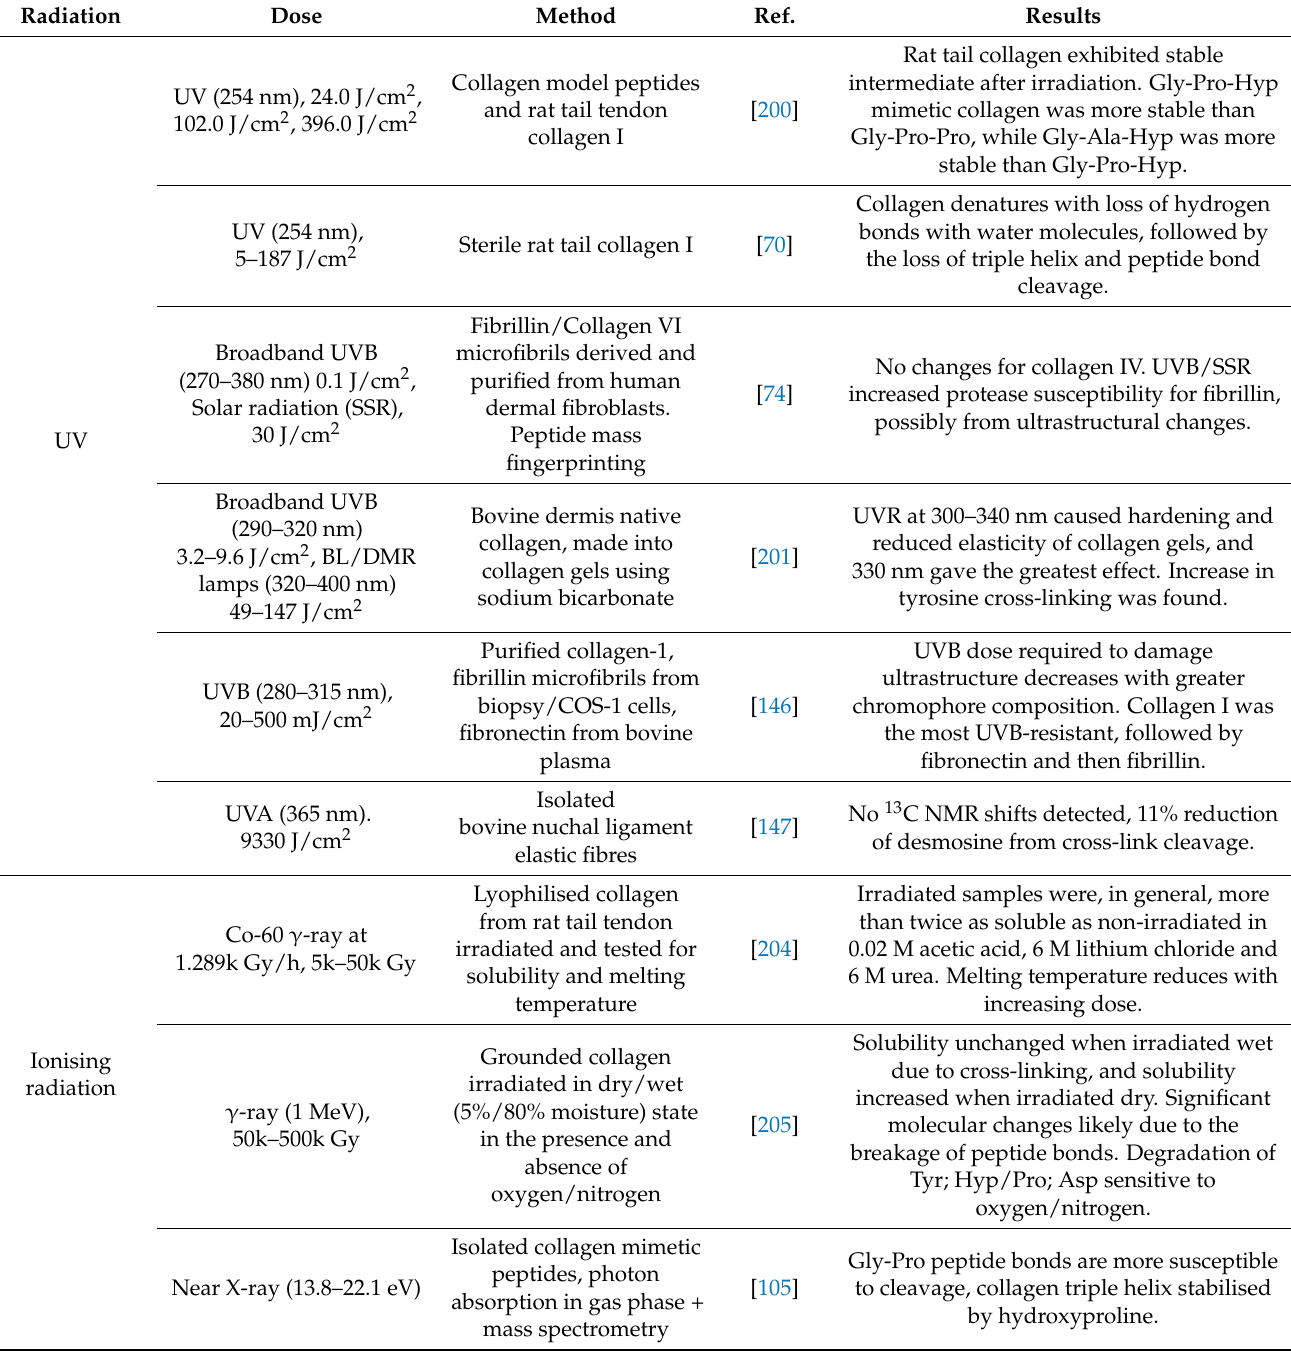
Table 2. Selected studies utilising purified ECM proteins for radiation damage experiments are useful to elucidate molecular mechanisms of radiation responses for individual ECM proteins. Most studies show that purified collagens in solution are relatively resistant to UVR at physiological doses which can affect other ECM proteins. Ionising radiation, however, induces significant structural change and peptide bond cleavages albeit at at non-physiological